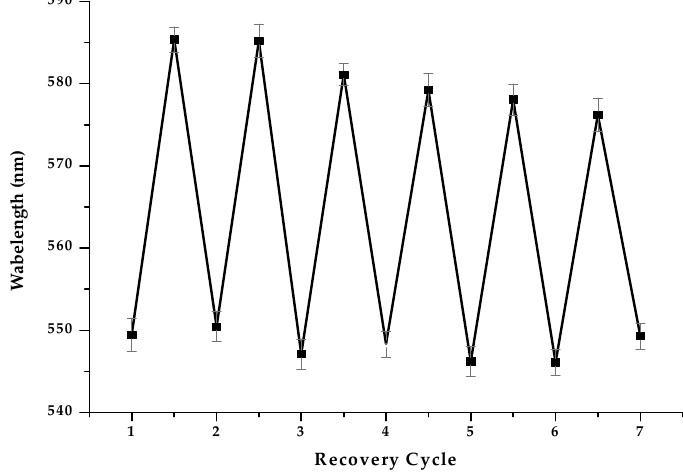
Figure 6. Reusability of the MIPC film.